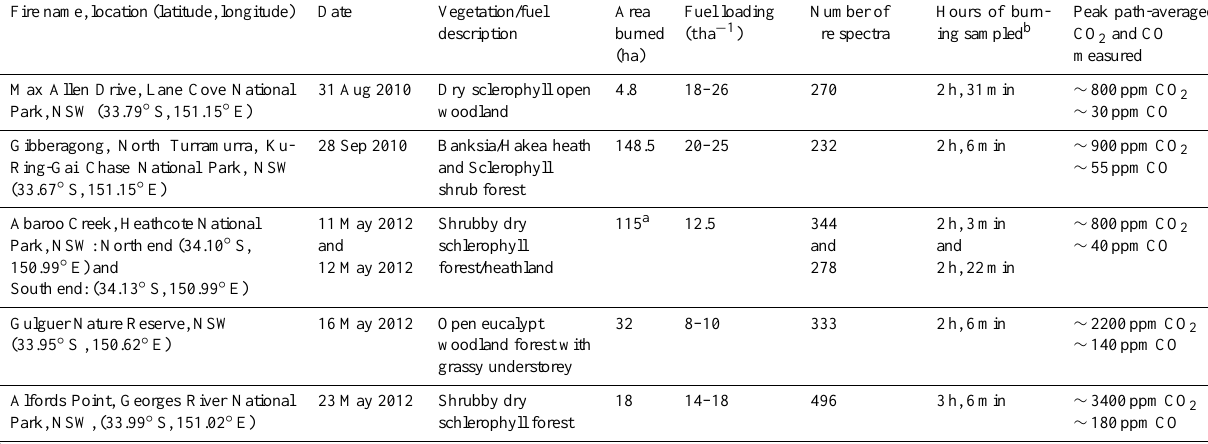
Table 2. Summary of hazard reduction burns where measurements were made, including location, date, vegetation type, burned area, fuel loading before burn along with the hours of burning sampled, the total number of fire-influenced spectra collected and the peak mole fractions of CO 2 and CO